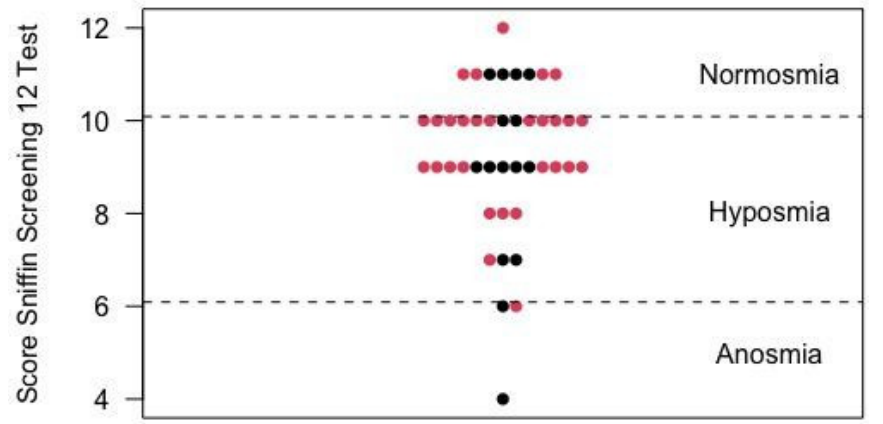
Figure 3. Scores odor identification test of the 44 participants (red: women, black: men).